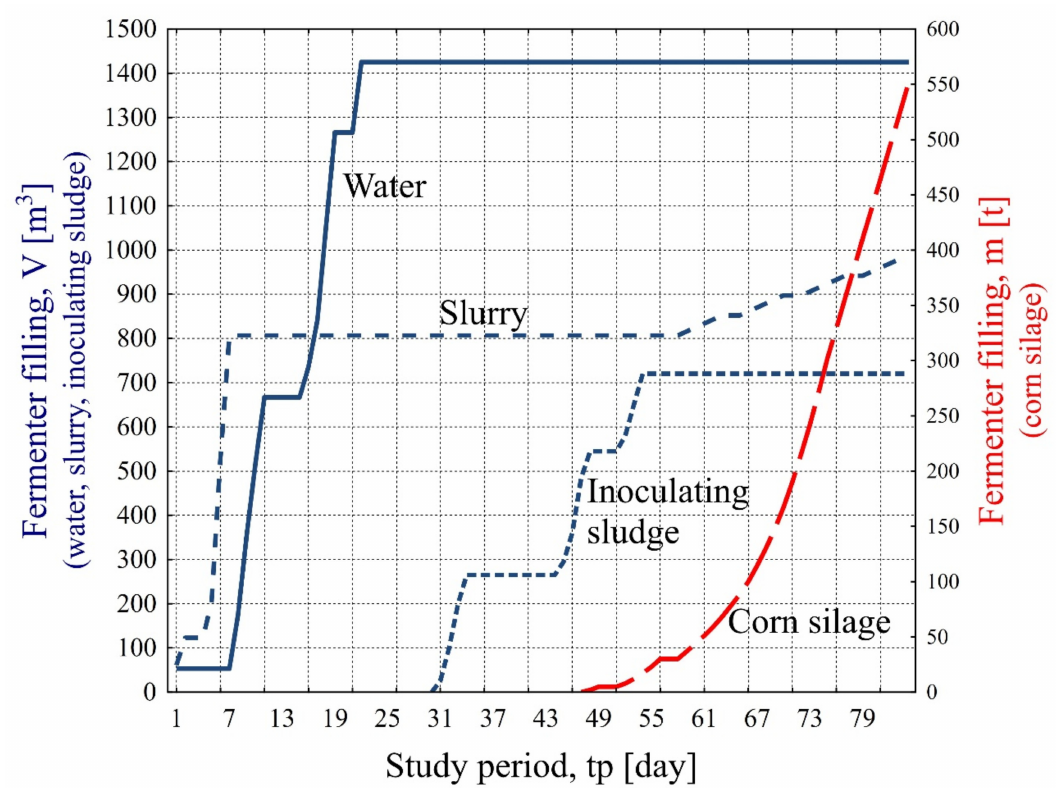
Figure 1. Filling of the fermenter V [m 3 ] depending on the duration of the start-up of the biogas installation tp [day] using water, corn silage, a mixture of pig and cattle liquid manure and inoculated sludge.